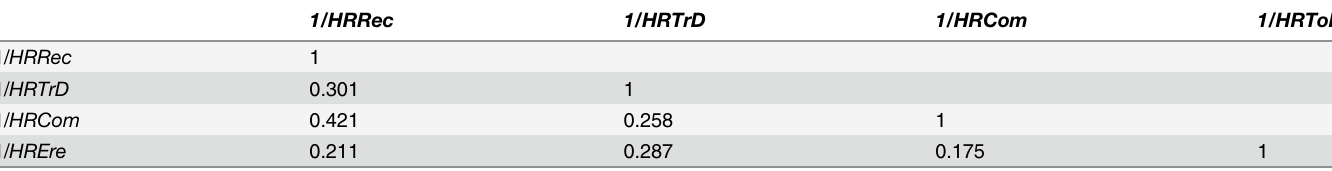
Table 3. Pearson correlation